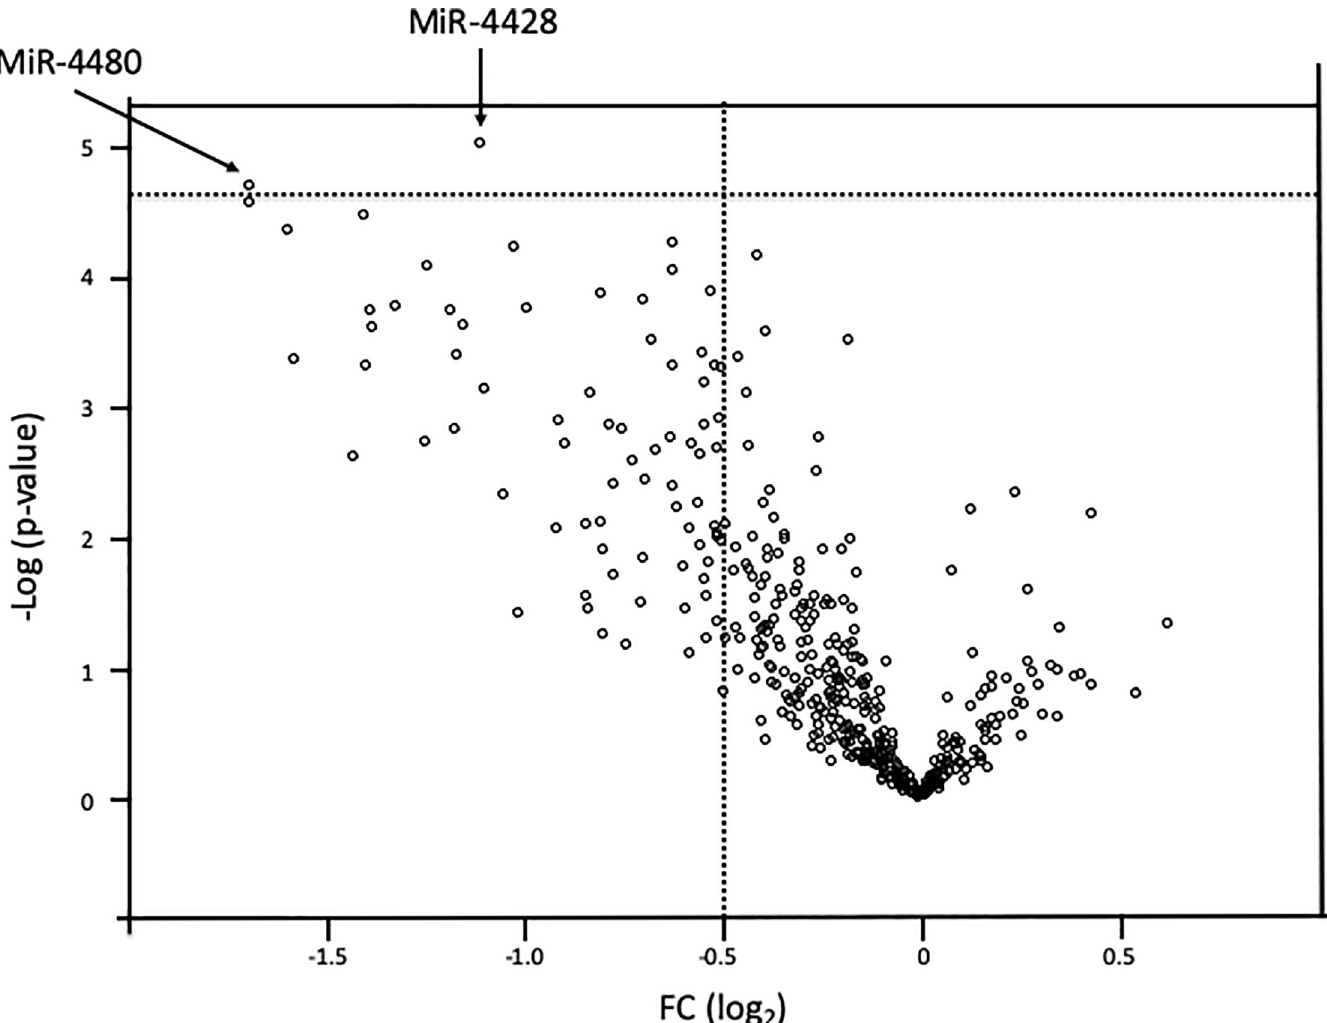
Fig 3. Volcano plots of microRNAs. FC, fold-change. Vertical dashed line shows the border of > 0.5 |foled change| Horizontal dashed line shows the border of > 0.01 p- value.